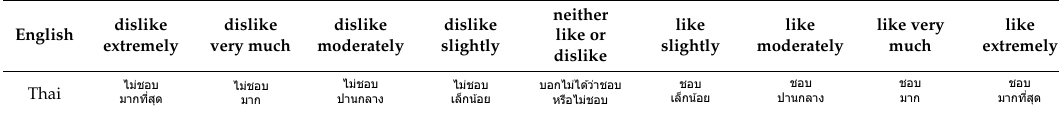
Table 2. The nine-point hedonic scale direct translation in to Thai. English